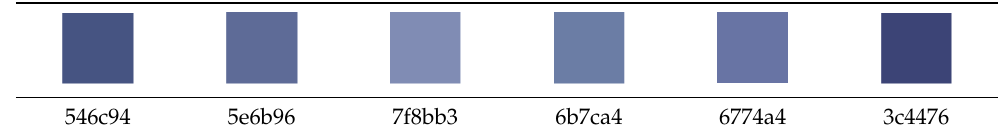
Table 13. Possible colors for ’dayflower Blue’ extracted from an ukiyo-e print Butterflies around a wine jar [38] mentioned in study [6].